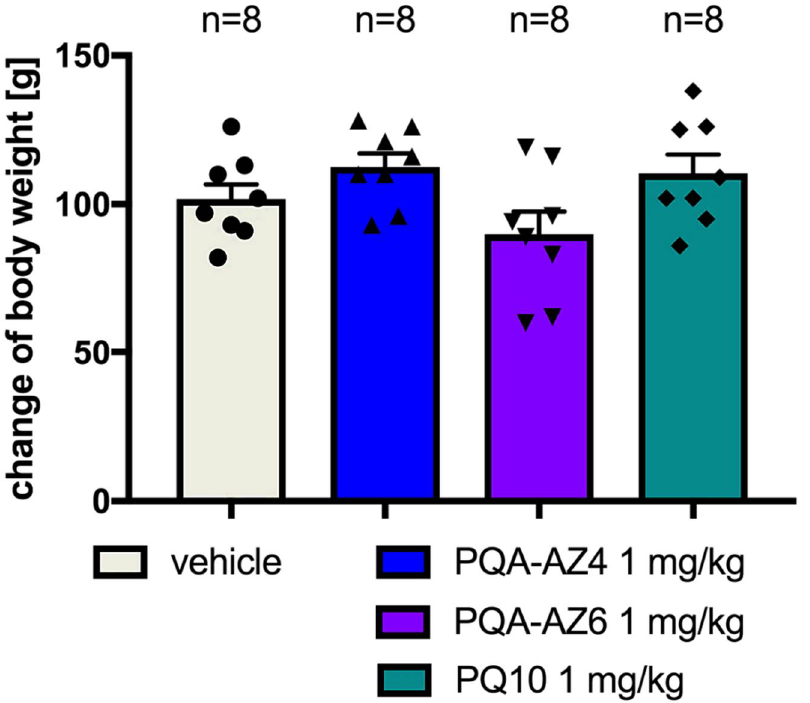
Figure 5. Effects of repeated administration of PQ-10, PQA-AZ4, and PQA-AZ6 on body weight in rats. PQA-AZ4 and PQA-AZ6 were administered i.p. once daily for 21 consecutive days. Data represent the mean ± SEM, n = 8 rats per group; statistical analysis was performed using the Student’s t -test.